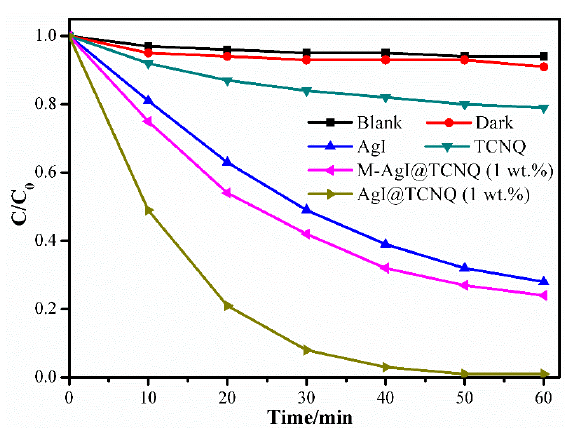
Figure 7. Photodegradation activities with different conditions.